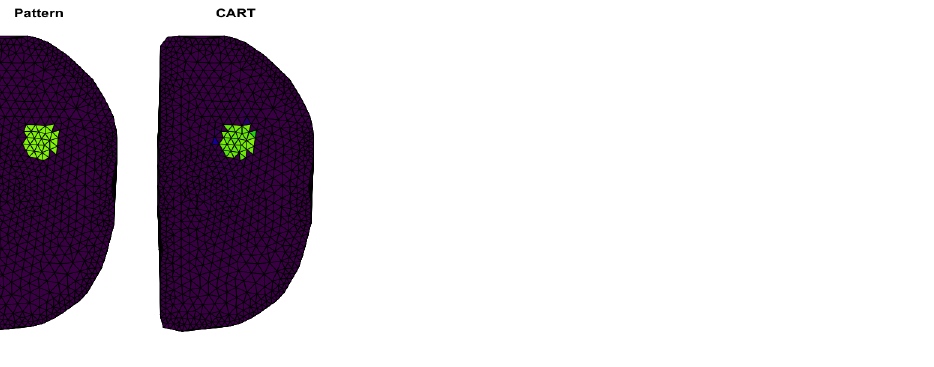
Figure 12. The first panel presents the inclusion shape. The second panel shows reconstruction obtained by CART.